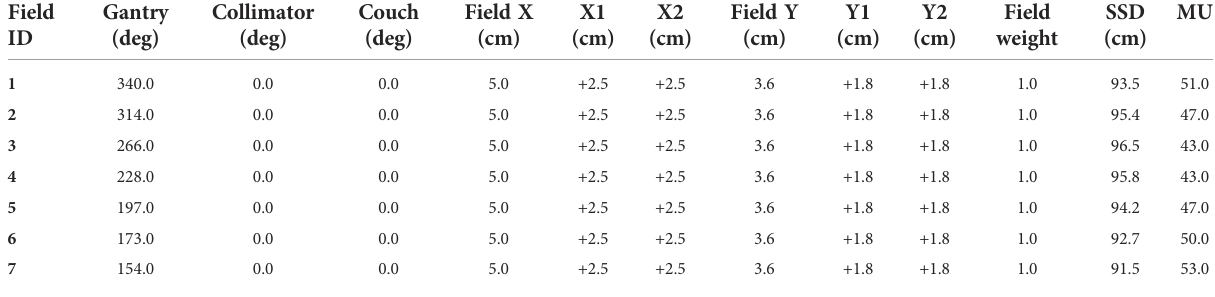
TABLE 2 IMRT planning dose